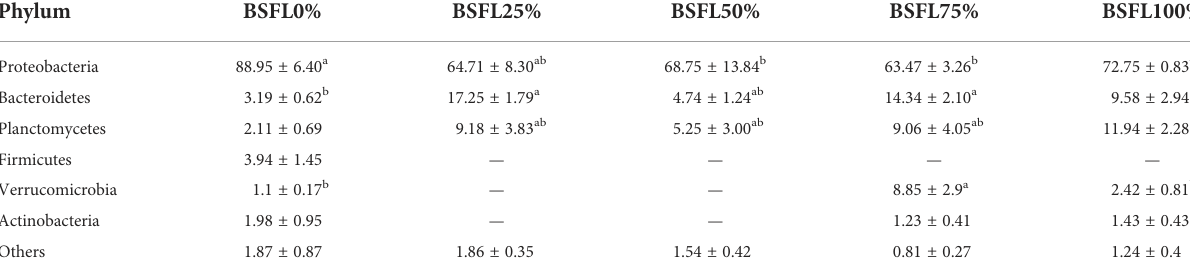
TABLE 6 Percentage abundances (%) of bacterial phyla in the intestine of L. vannamei . Phylum